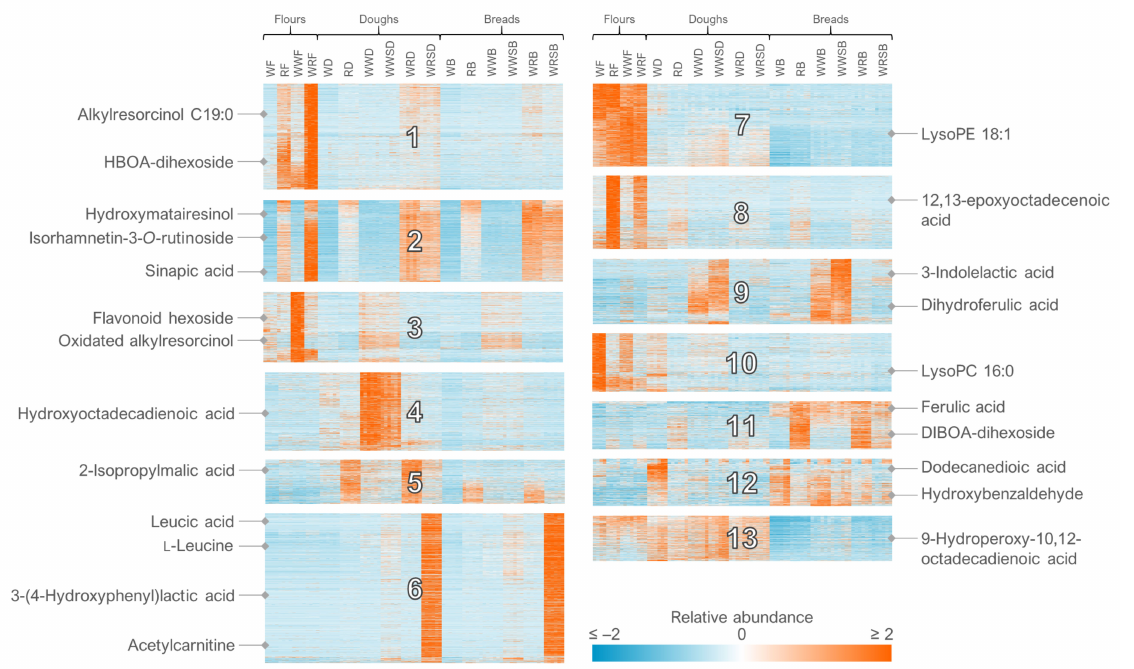
Figure 25. Heat map of all the 12,579 molecular features detected in reversed phase negative mode from cereal samples with some of the annotated compounds highlighted. k -Means clustering was applied to the dataset, dividing it into distinct clusters ( n = 13) based on the relative abundance of the features across